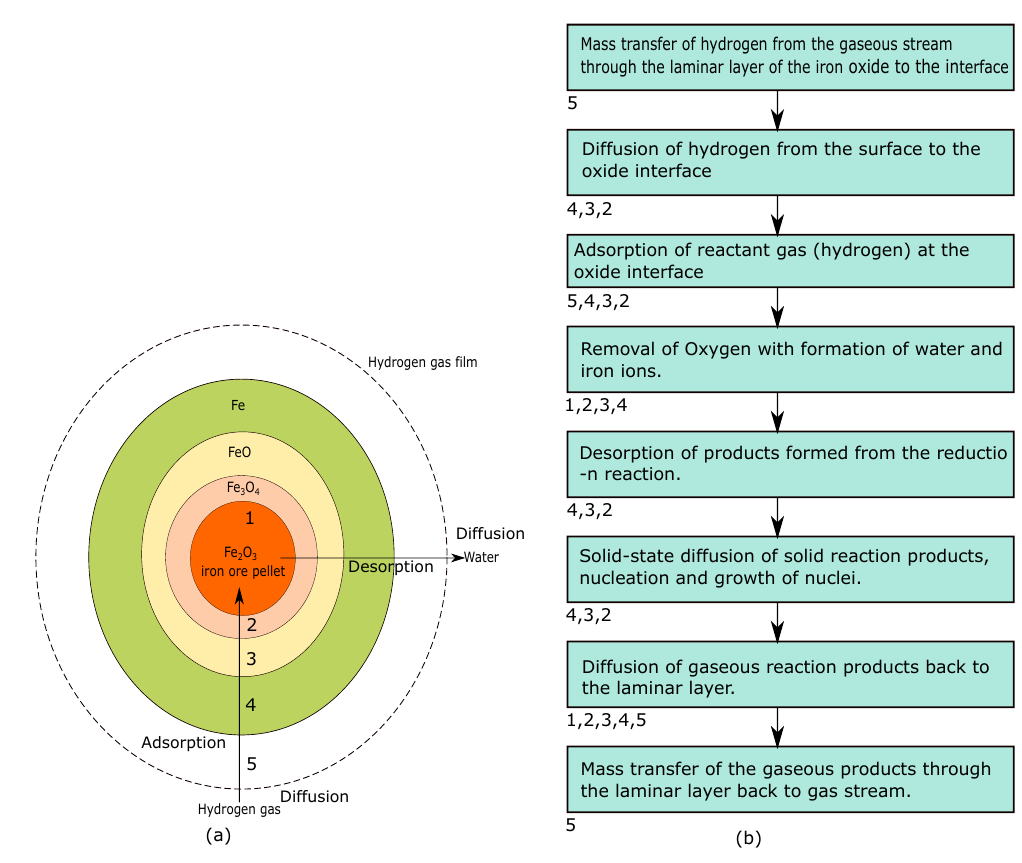
Figure 1. ( a ) Shrinking core model depicting the evolution of iron ore reduction reaction with hydrogen [56]. ( b ) Process steps in the reduction of iron ore pellets with hydrogen [37]. The location of the process steps is represented from numbers 1 to 5 (1b), which are also depicted in the shrinking core model